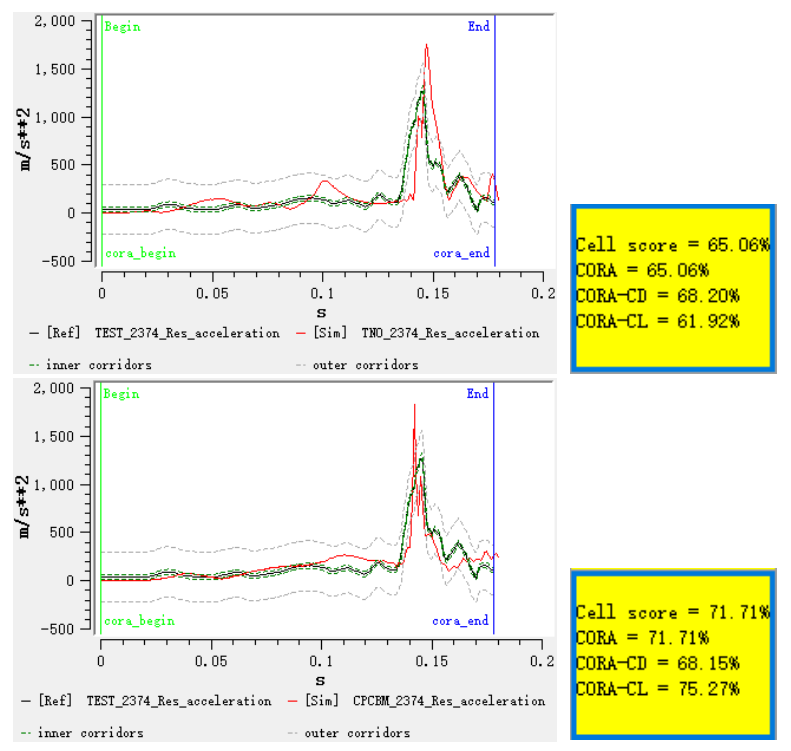
Figure A15. Resultant acceleration signals between experiment and simulation.